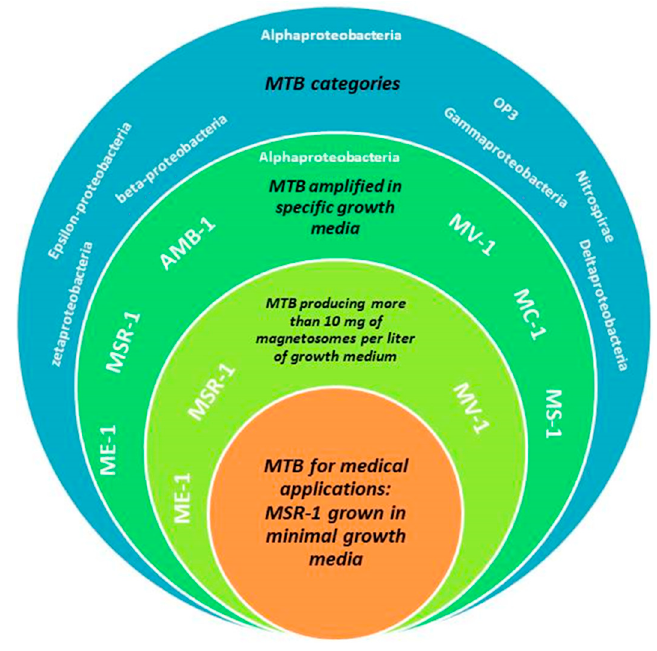
Figure 1. A schematic diagram presenting the various categories of magnetotactic bacteria (blue background), species of magnetotactic bacteria belonging to Alphaproteobacteria that can be amplified in specific growth media (dark apple green background), species of magnetotactic bacteria belonging to Alphaproteobacteria that can be amplified in specific growth media and can produce more than 10 mg of magnetosomes per liter of growth medium (yellow green background), MSR-1 specie belonging to Alphaproteobacteria that can be amplified in specific growth media, can produce more than 10 mg of magnetosomes per liter of growth medium, and can be amplified in minimal growth media not containing peptone, yeast extract, toxic CMR products, and heavy metals.